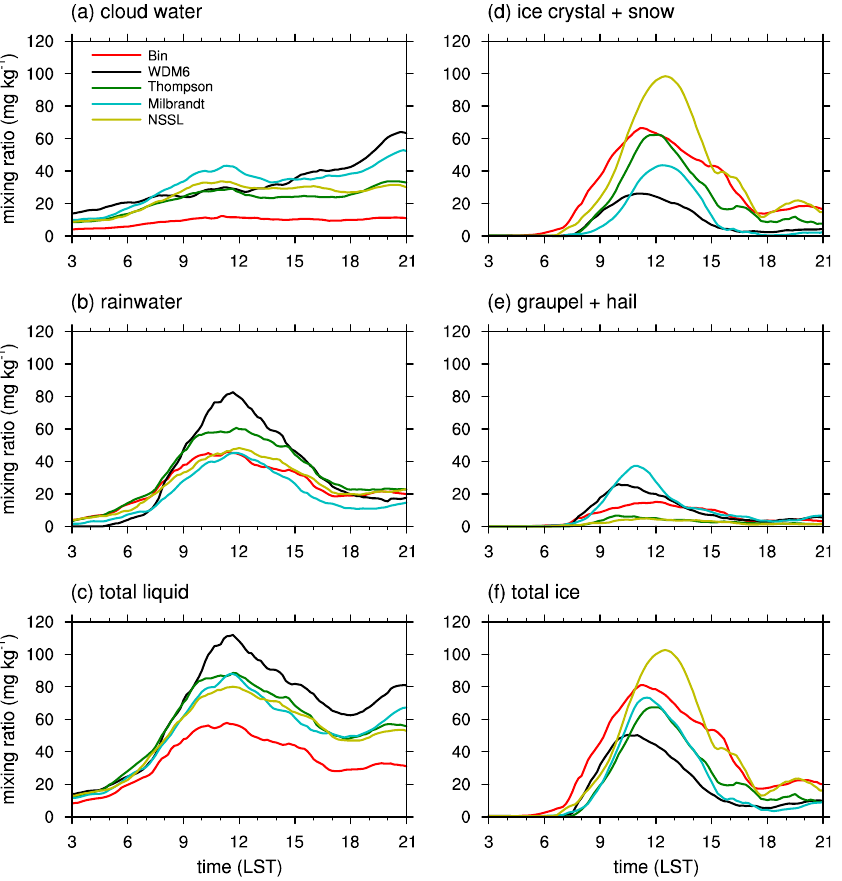
Figure 5. Time series of domain-averaged mixing ratios of ( a ) cloud water, ( b ) rainwater, ( c ) total liquid water (the sum of cloud water and rainwater), ( d ) pristine and aggregated ice particles (ice crystal and snow), ( e ) rimed ice particles (graupel and hail), and ( f ) total ice particles (the sum of pristine and aggregated and rimed ice particles). Note that the WDM6 and Thompson–Eidhammer schemes consider graupel as the only rimed ice particles.